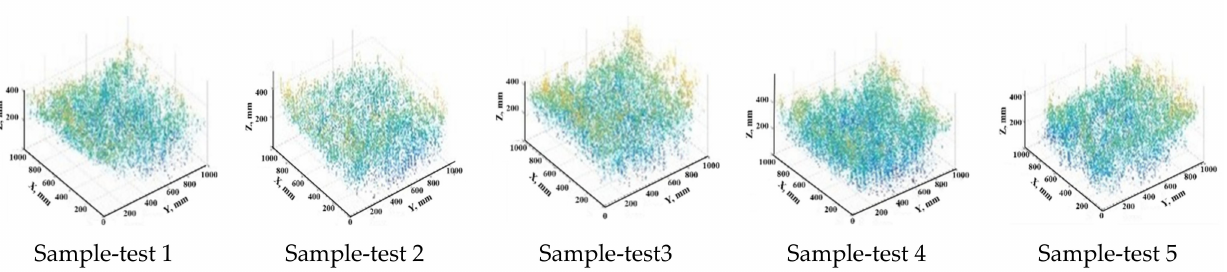
Figure 10. The segmentation results of random experiment group based on double-threshold.